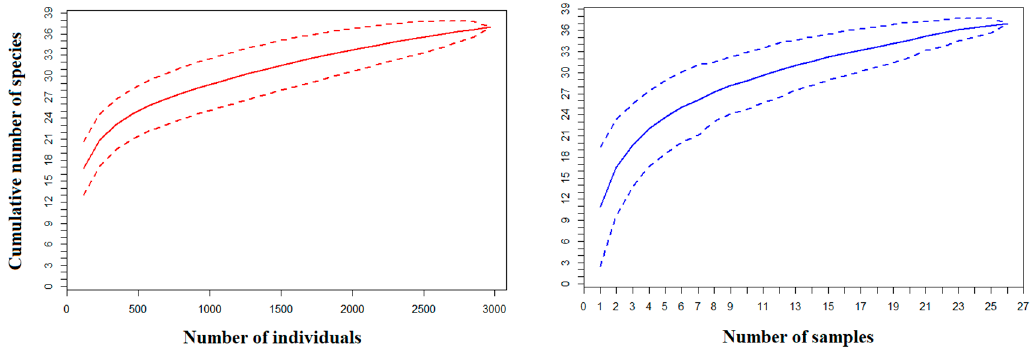
Figure 2. Species rarefaction curves in upstream Lijiang River. Left : Individual-based rarefaction curve; right : sample-based rarefaction curve.